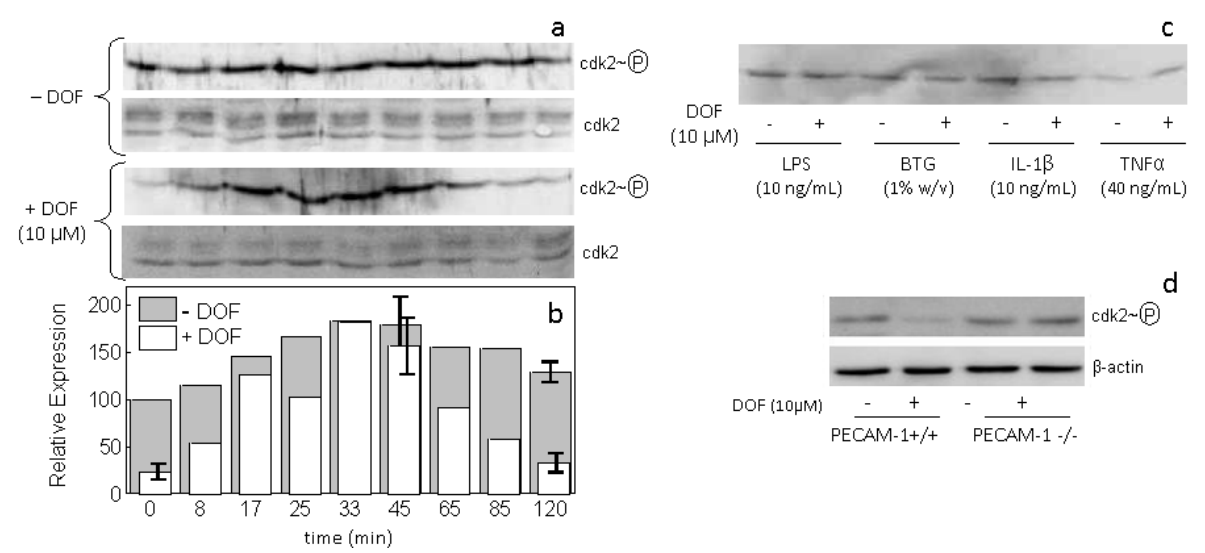
FIGURE 7. The effect of DOF on constitutive and agonist-induced phosphorylation of cdk2. (a) Western blot analysis for active cdk2 was performed on cytosolic fractions from whole cell lysates of RPMΦ following treatment with 1% BTG over the time course shown. In all cases, protein loading was based on equal numbers of cells extracted and where visual inspection of the transblots following Ponceau Red staining confirmed equivalent protein loading. Separate gels were run for either phospho-CDK2(Thr160) or total cdk2 in which transblots were also probed for β-actin. (b) Chemiluminescence in (a) was quantitated and normalized to the relative expression of untreated cells at t = 0 min. The experiment was repeated a further two times, but where cells were extracted only at 0, 45, and 120 min time points. Error bars represent 95% CI. (c) Western blot analysis for active cdk2 in cytosolic fractions prepared from RPMΦ treated with various agonists for 45 min either in the presence or absence of DOF (10 μM). (d) Western blot analysis for active cdk2 in cytosolic fractions from PECAM-1 +/+ or PECAM-1 –/– RPMΦ treated with or without DOF in the absence of any other stimulus. A β-actin blot is also shown as a control for loading and equal numbers of cells